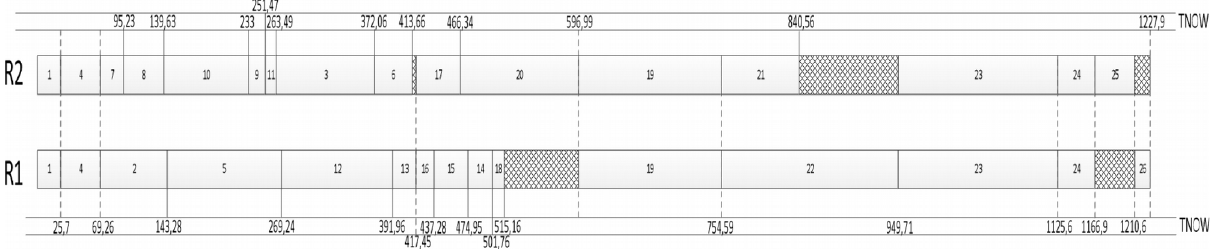
Figure 12. Gantt Chart for the ACTIM, ACTRES, dan TIMRES Scheduling (Scenario 3)